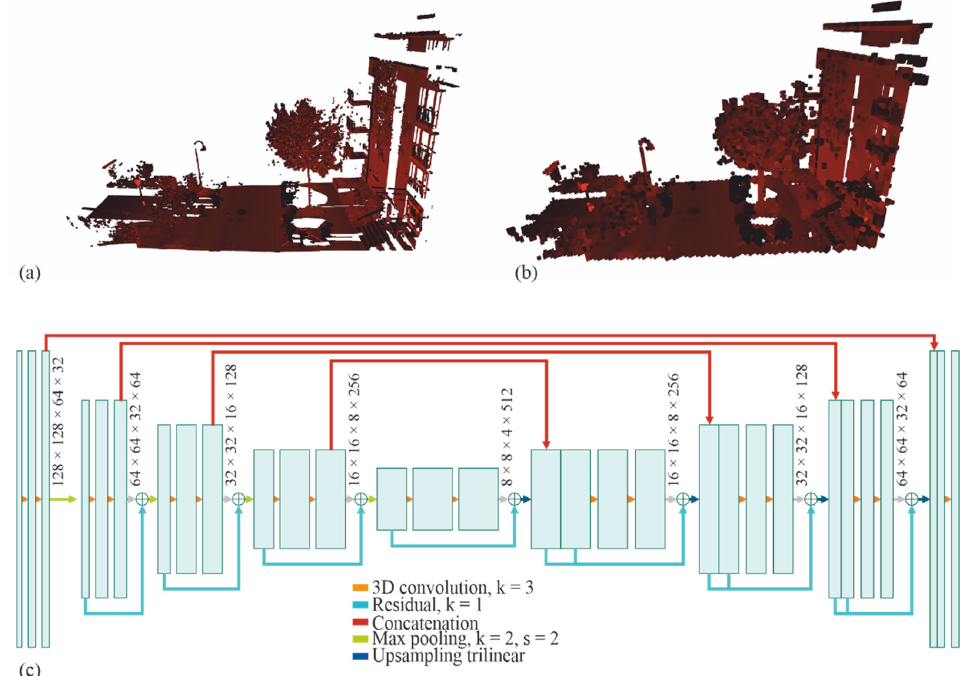
Figure 4. ( a ) Exemplary point cloud in original resolution and ( b ) the resulting discretized version consisting of evenly arranged voxels that is used as input for the neural network. The input parameters are combinations of the x, y and z coordinate, the mean intensity, the mean differential absorption value and the number of 3D points of each voxel. ( c ) shows a schematic depiction of the architecture of the neural network implemented in this study. The parameter k describes the kernel size, the parameter s denotes the stride. A more detailed explanation of the individual steps and the discretization process can be found in the text.